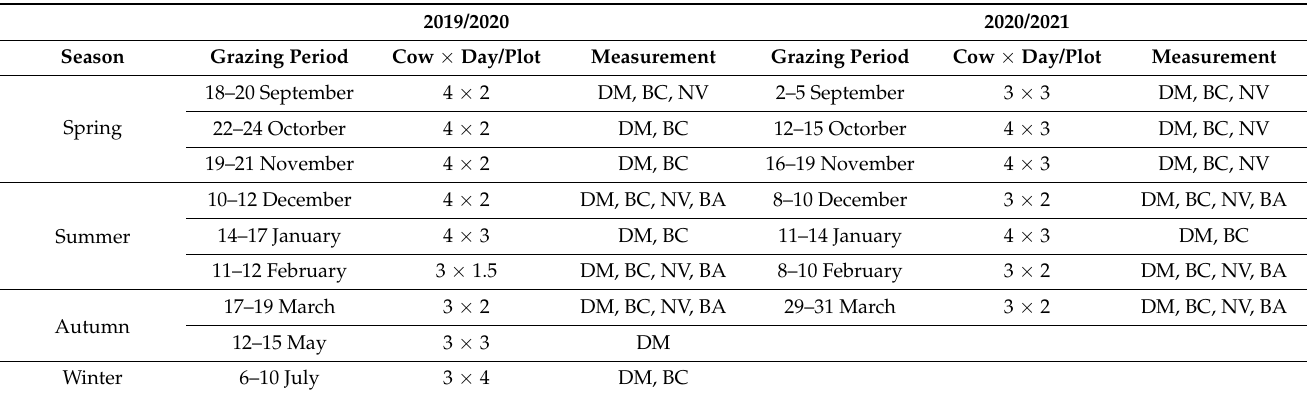
Table 2. Season, grazing period, number of cows and days grazing in each plot, and pasture measurements for grazing events from September 2019 to March